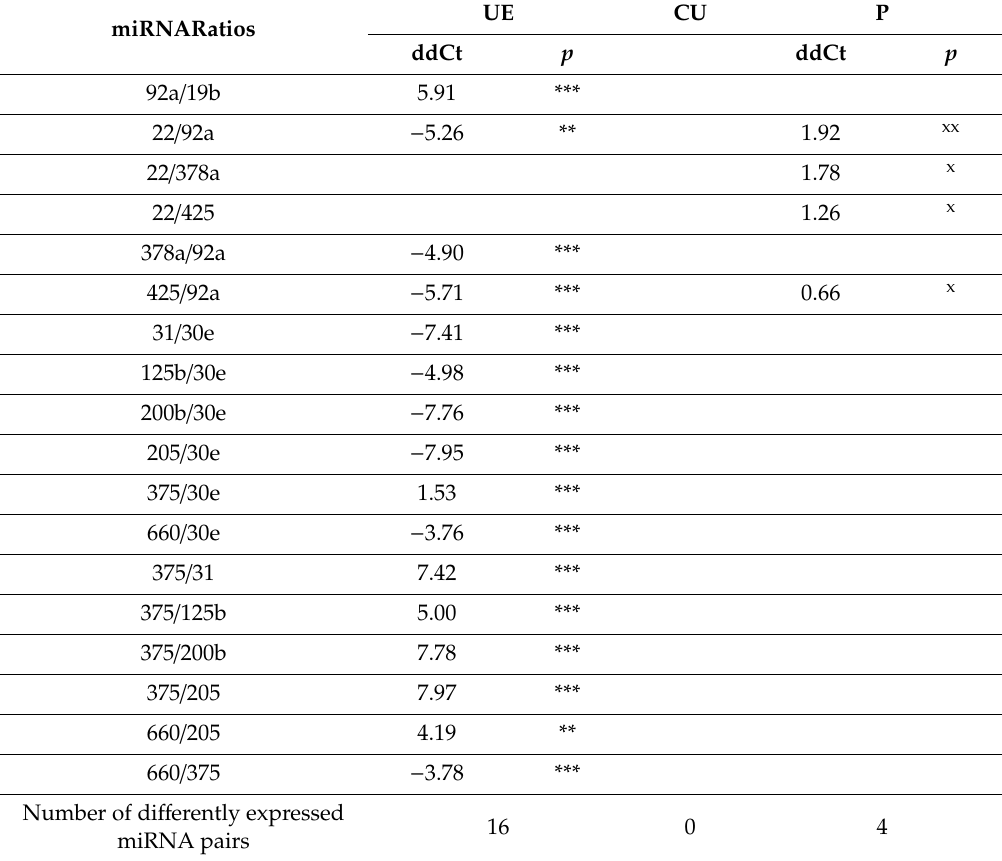
Table 3. ddCt mean values for di ff erentially expressed miRNA pairs in prostate cancer patients after radical prostatectomy and healthy